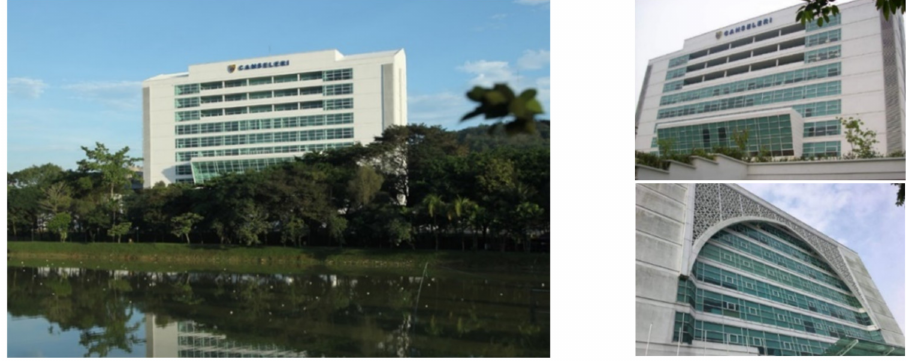
Figure 3. Universiti Malaya Chancellery